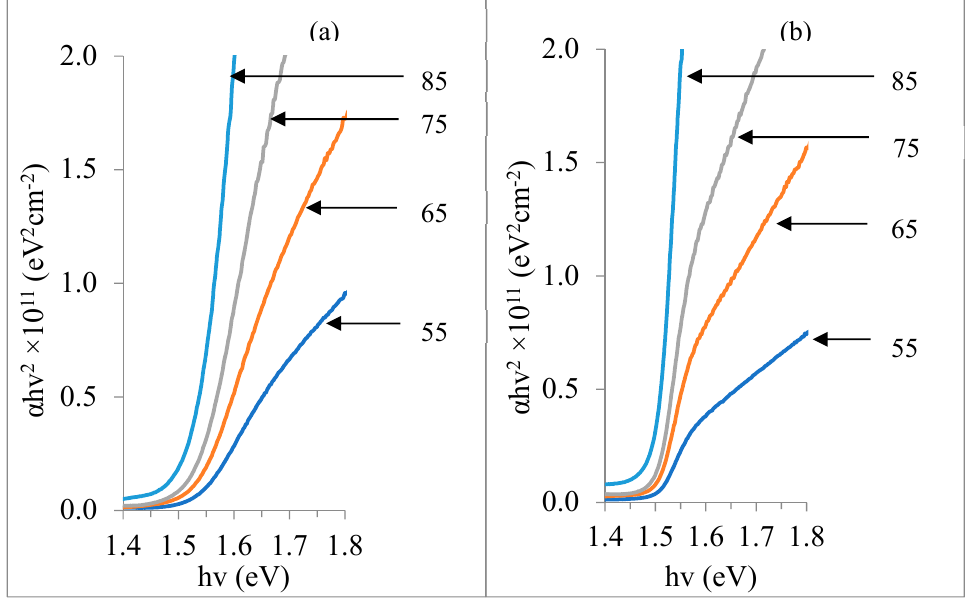
Figure 5. A plot of the estimated and measured thicknesses (as-deposited) and the average current density during electroplating against the electroplating temperature for CdTe layers grown for 180 min.